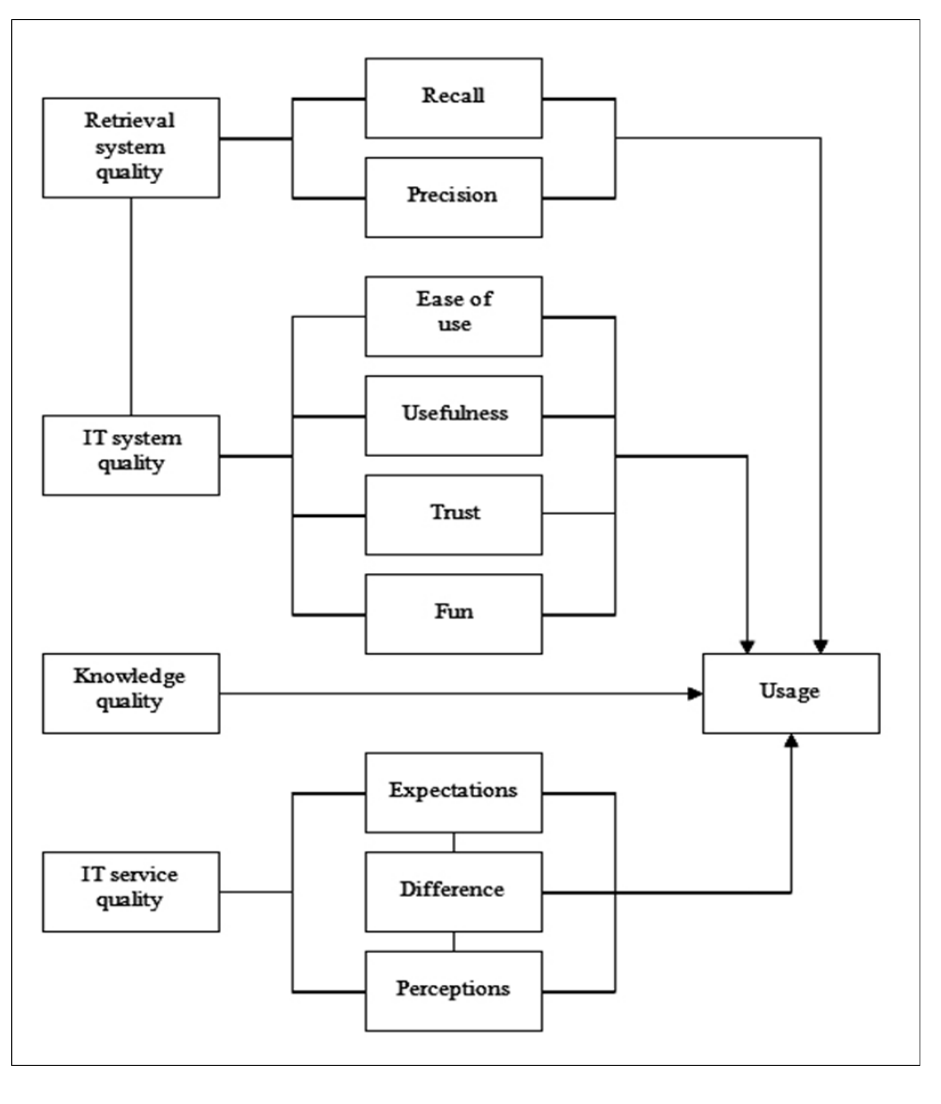
Figure 5. IT success model used for